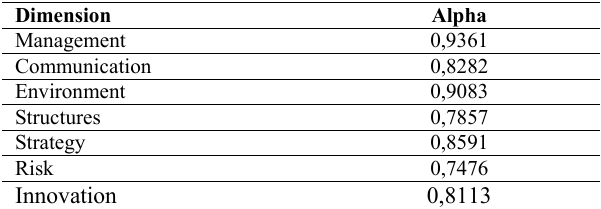
Table 2: Cronbach’s Alpha for the dimensions